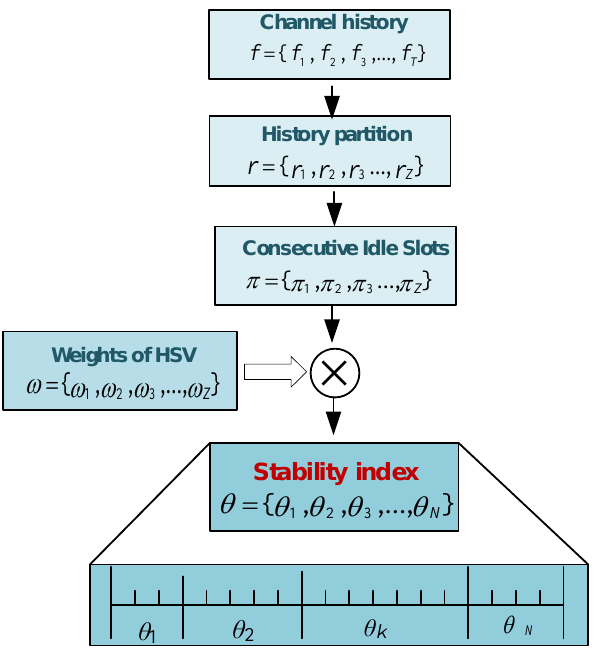
Figure 3. Stability-index calculation